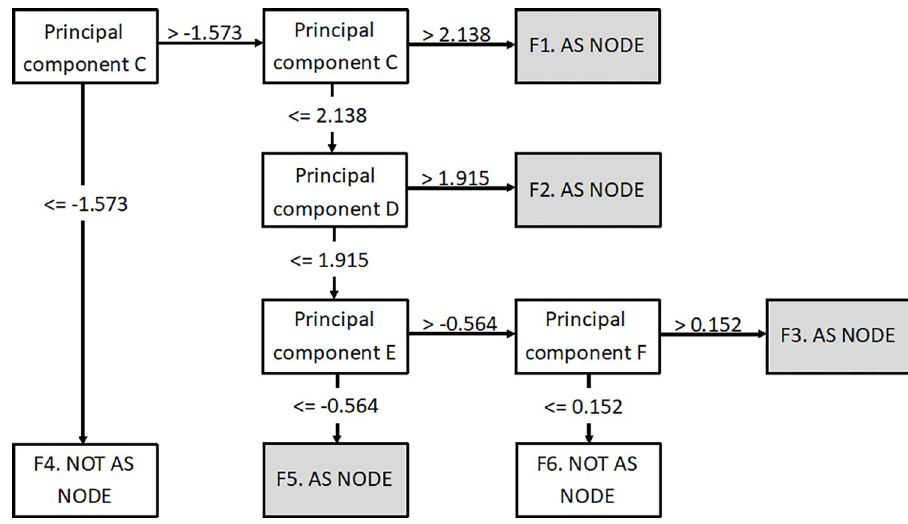
Fig 3. Combined results of machine learning (female).